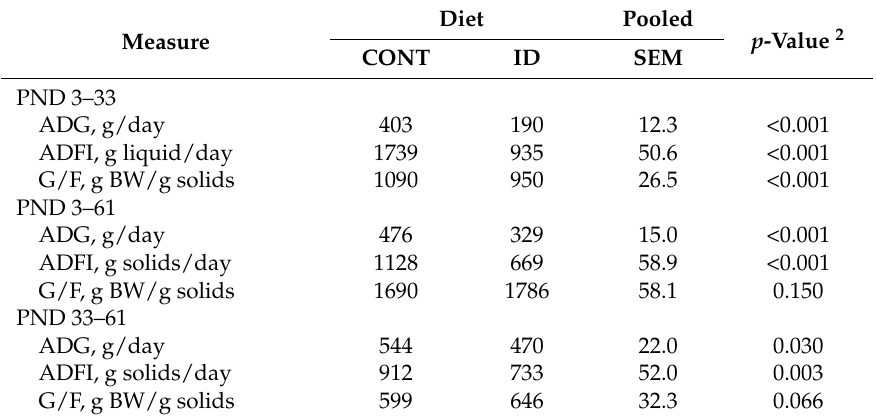
Table 1. Growth performance of pigs differing in early-life iron status 1 .